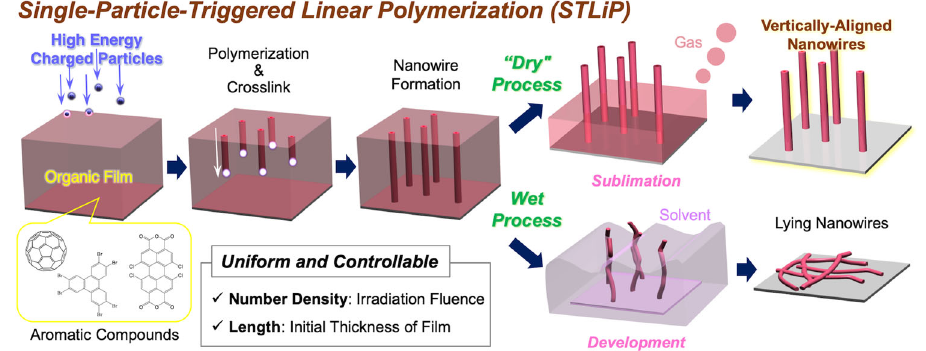
Fig. 1 Nanowire fabrication process. Schematic illustration of fabrication and isolation of knocked-down(lying)/standing(vertically-aligned) organic nanowires via polymerization reactions in ion tracks triggered by irradiation with high-energy charged particles